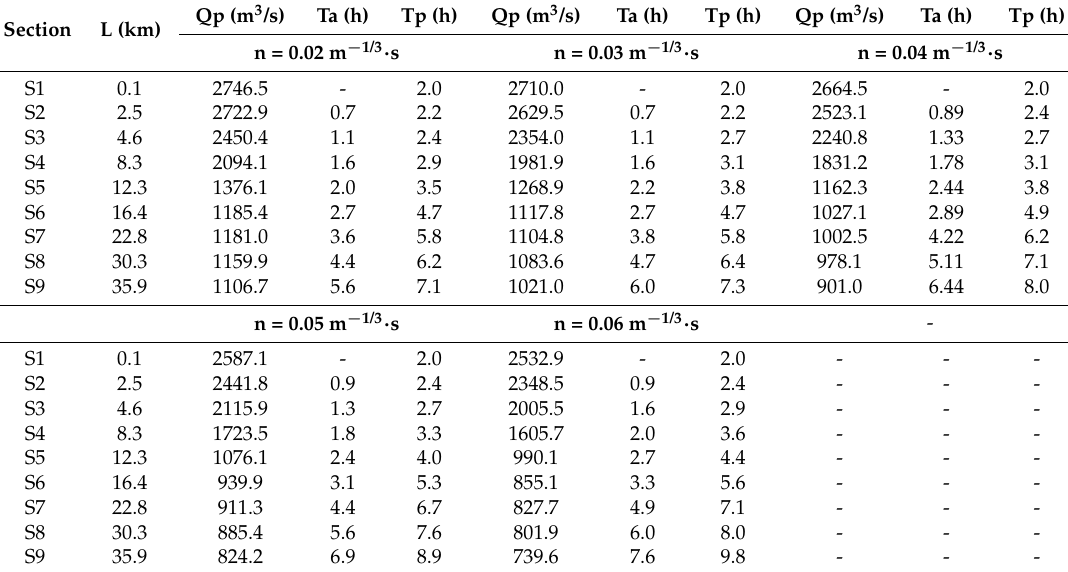
Table 2. Peak flow (Qp), arrival time (Ta) and peak time (Tp) of the flood wave at downstream sections in Scenario B (DEM SRTM TR ) considering different roughness coefficients